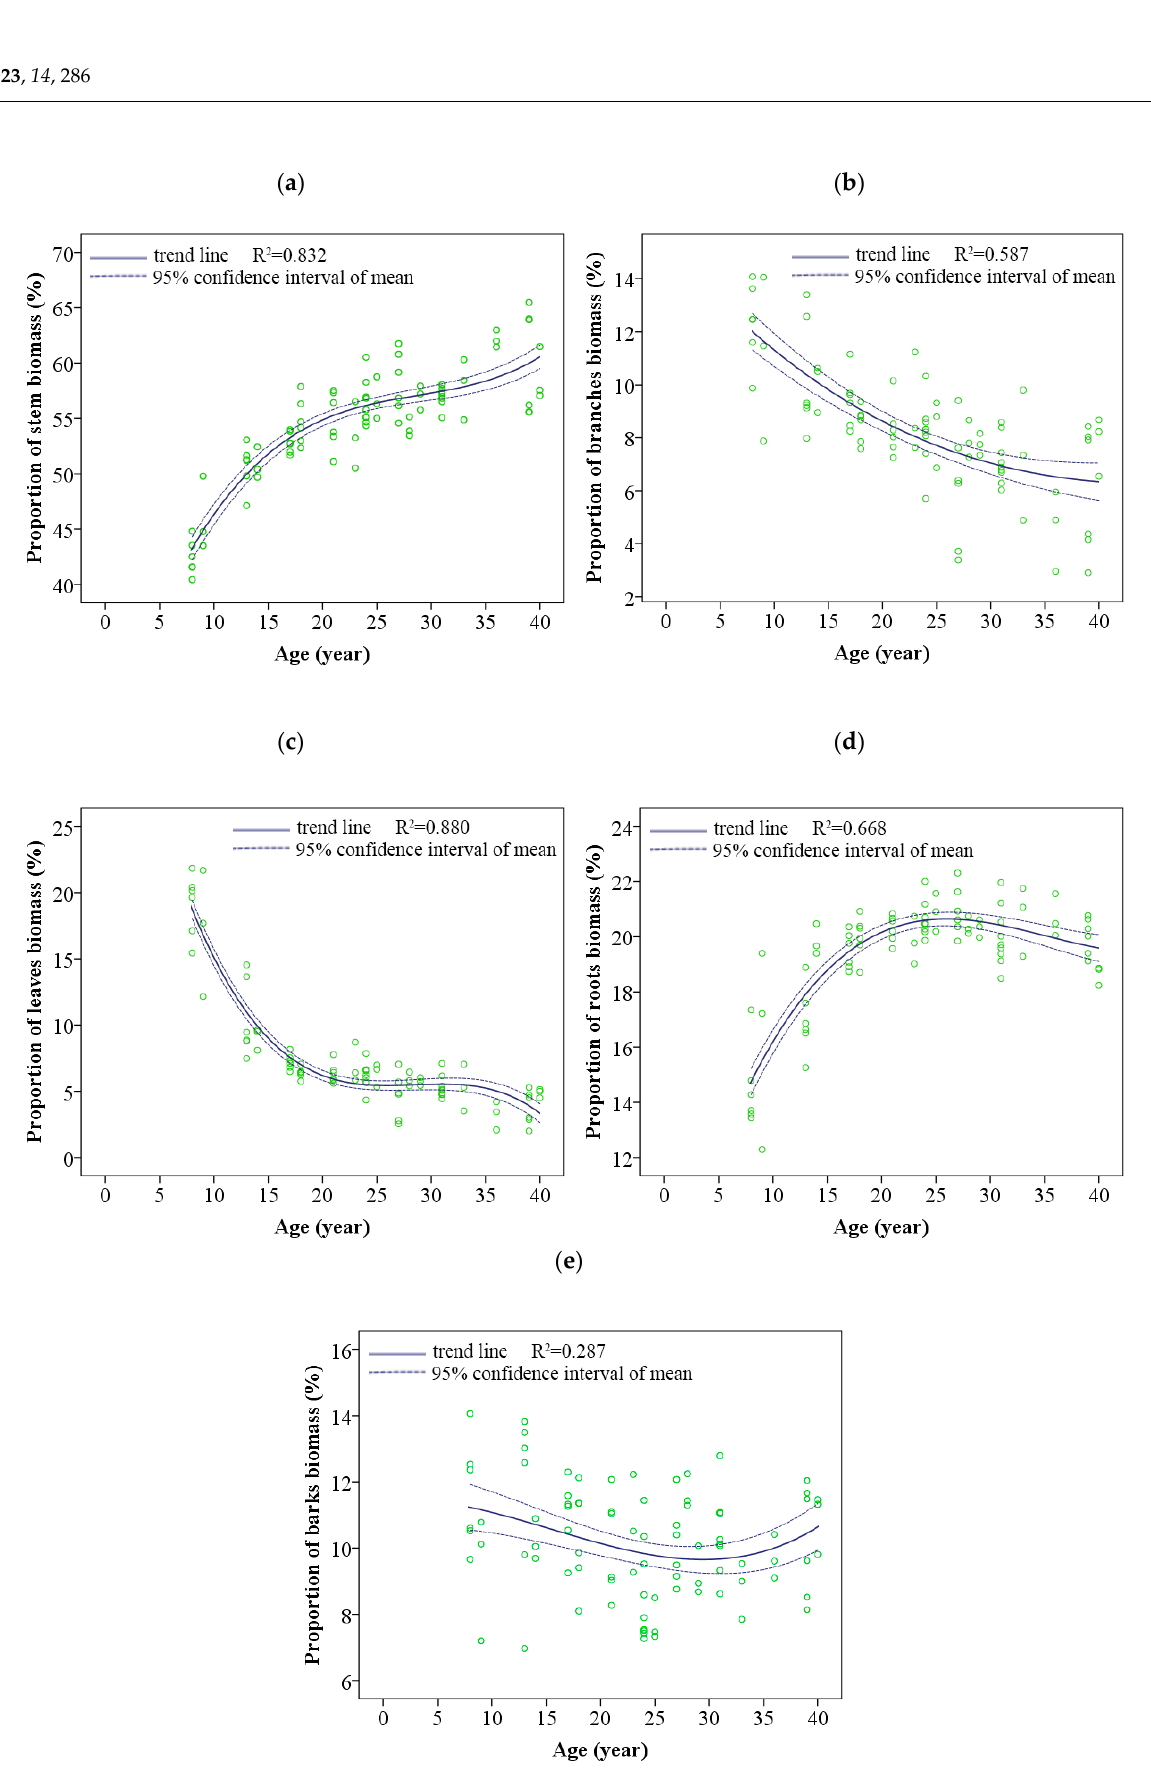
Figure 3. The change trend of the proportion of biomass for various organs with tree age in Chinese fir. ( a ) Stem, ( b ) branches, ( c ) leaves, ( d ) roots, and ( e ) bark.